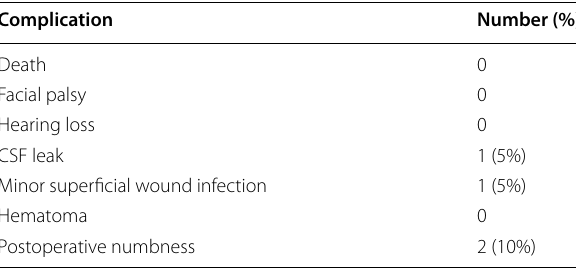
Table 2 Summary of postoperative